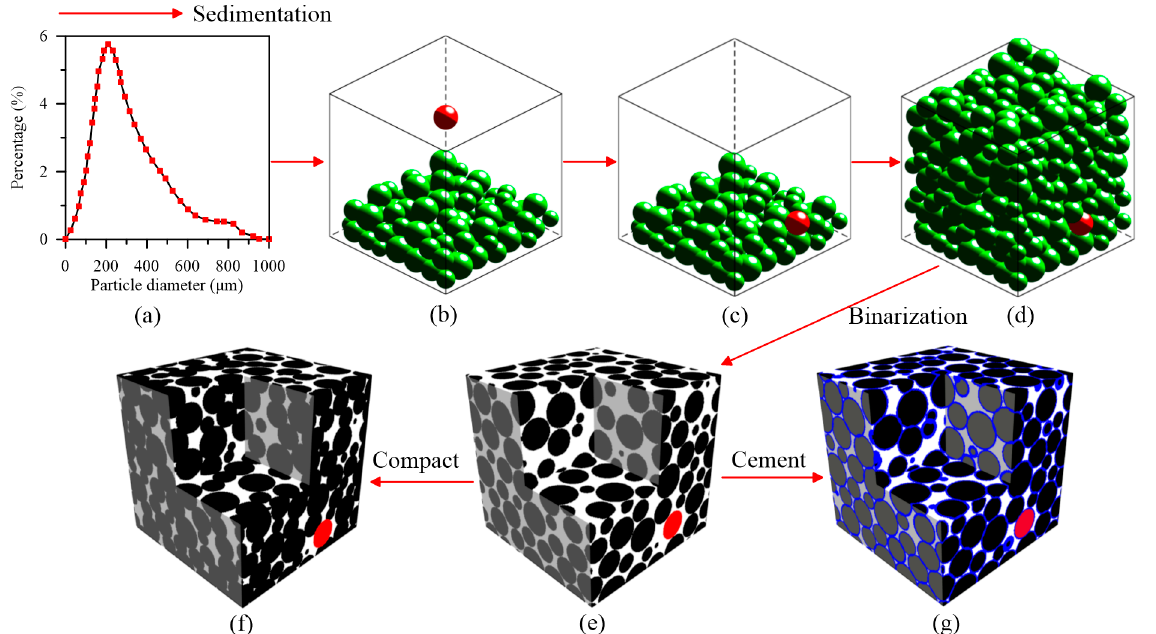
Figure 1. Three basic procedures for constructing 3D process-based model. ( a – d ) Sedimentation process; ( a ) Grain size distribution; ( b ) A new grain; ( c ) Find stable position; ( d ) Sedimentation model; ( e ) Binarization; ( f ) Compaction process; ( g ) Cementation process.